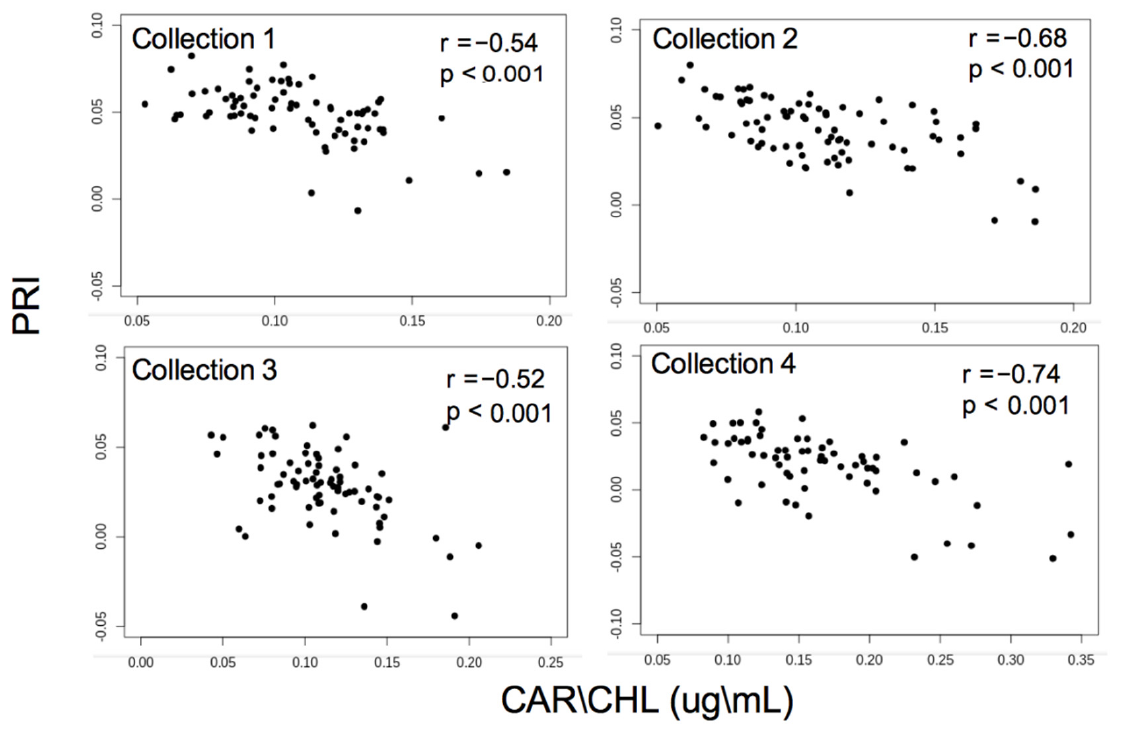
Figure 5. Correlation between photochemical reflectance index (PRI) and Car/Chl by collection, for 2018. See Table 2 for collection dates.